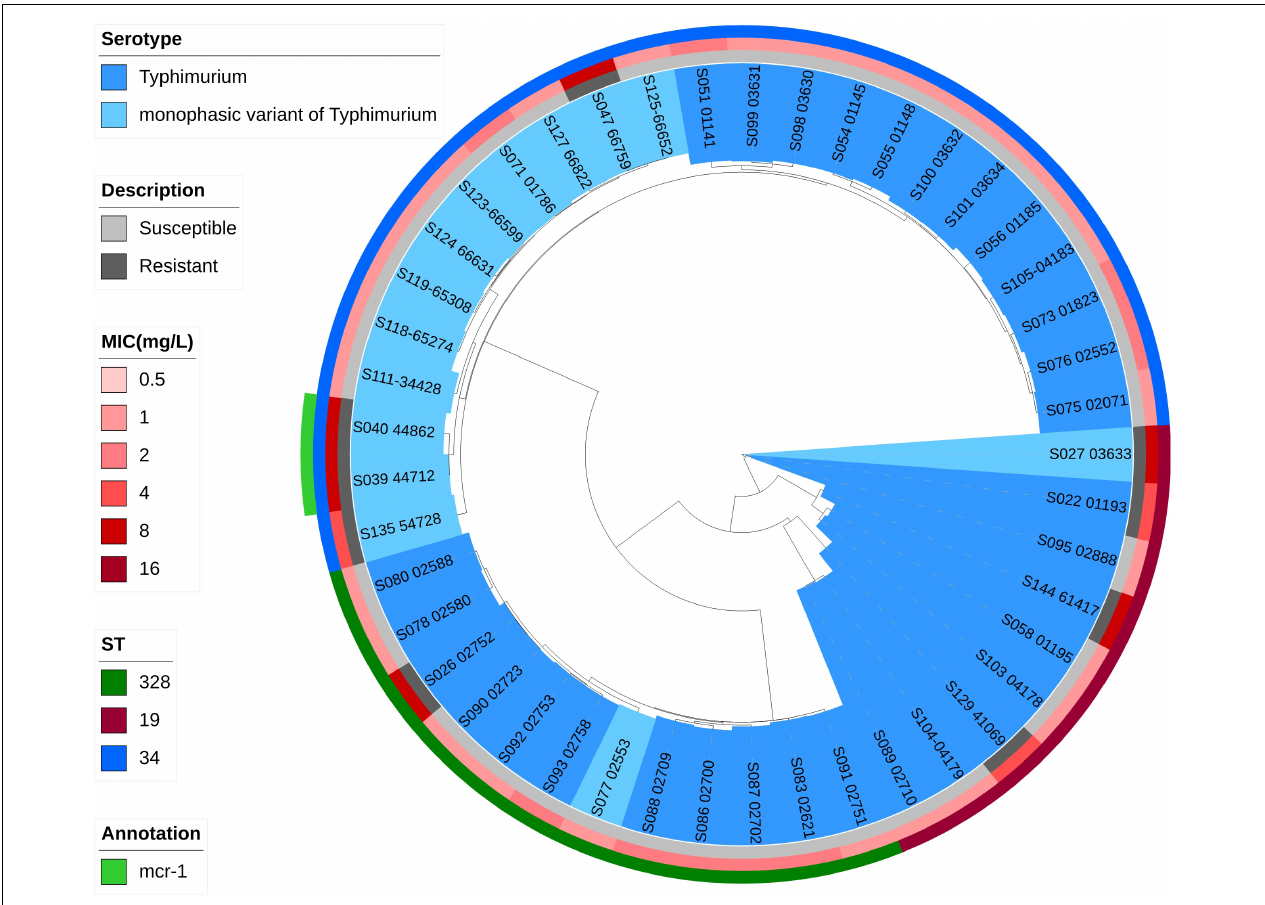
FIGURE 4 | Zoomed-in maximum parsimony tree showing the Typhimurium and monophasic variant of Typhimurium ( Salmonella 4,[5],12:i:-) serotypes sub-clade of the clinical Salmonella isolates. Colistin MICs in mg/L and sequence types are shown. For the description of colistin susceptibility, resistance corresponds to MIC > 2 mg/L and susceptible corresponds to MIC ≤ 2